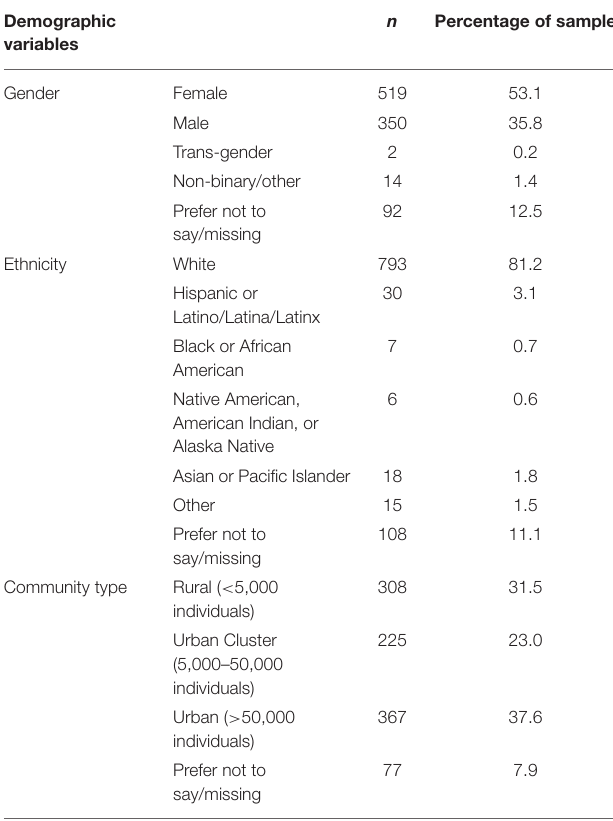
TABLE 2 | Demographic information of sampled